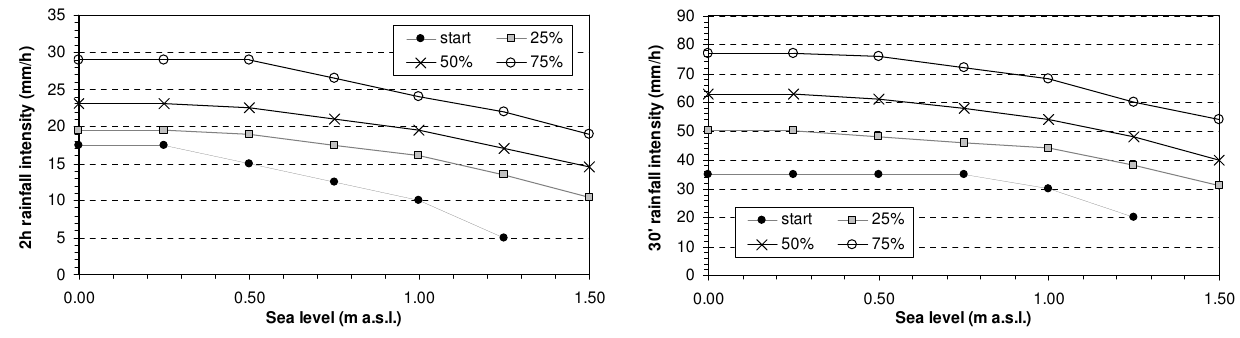
Fig. 8. Isolines representative of an equal percentage of flooded nodes as a function of average constant rainfall intensity (Duration: 2h, left panel; 30min, right panel) and of sea level at network outfall. “Start” condition represents the threshold condition right before flooding occurs.